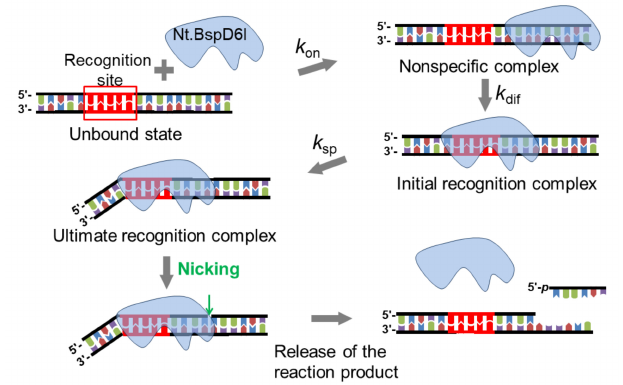
Figure 6. An outline of the mechanism behind the interaction of Nt.BspD6I with a substrate. k on : The rate constant for the formation of a non-specific complex, k dif : the rate constant for the search for a target sequence, k sp : the rate constant for the formation of specific contacts between the protein and DNA. The protein recognition site is red.